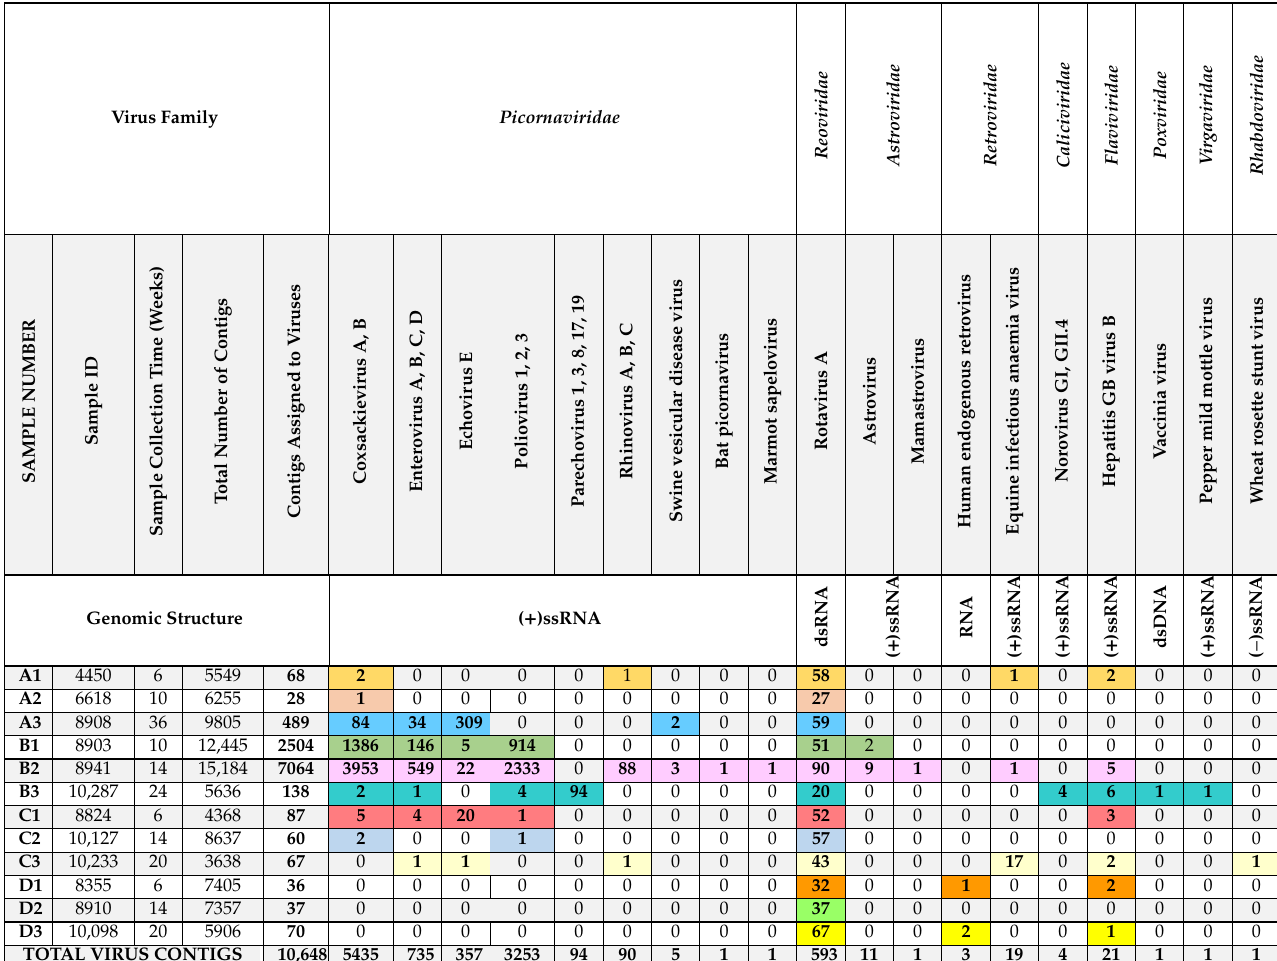
Table 2. Taxonomic distribution of detected viruses from assembled contigs per collected faecal sample.